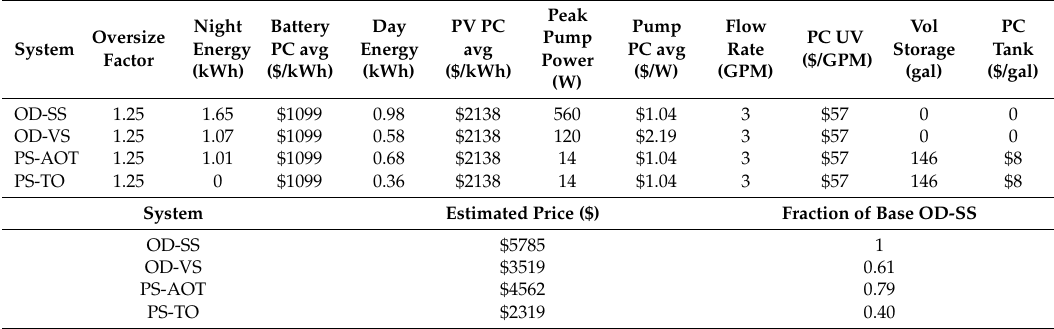
Table A11. Estimated cost calculations by